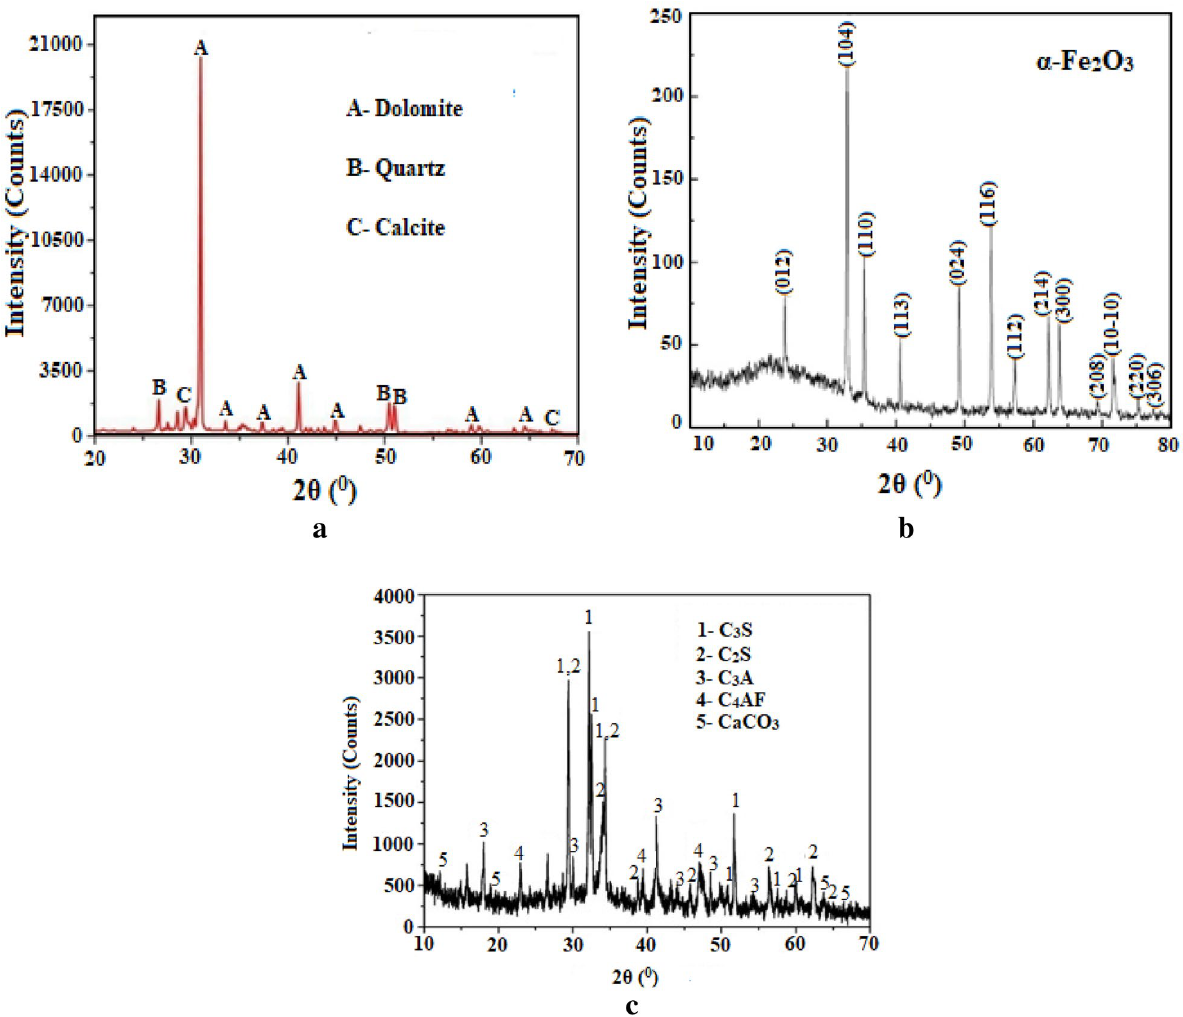
Fig. 1 a XRD pattern of MP, b XRD pattern of NF. c XRD pattern of